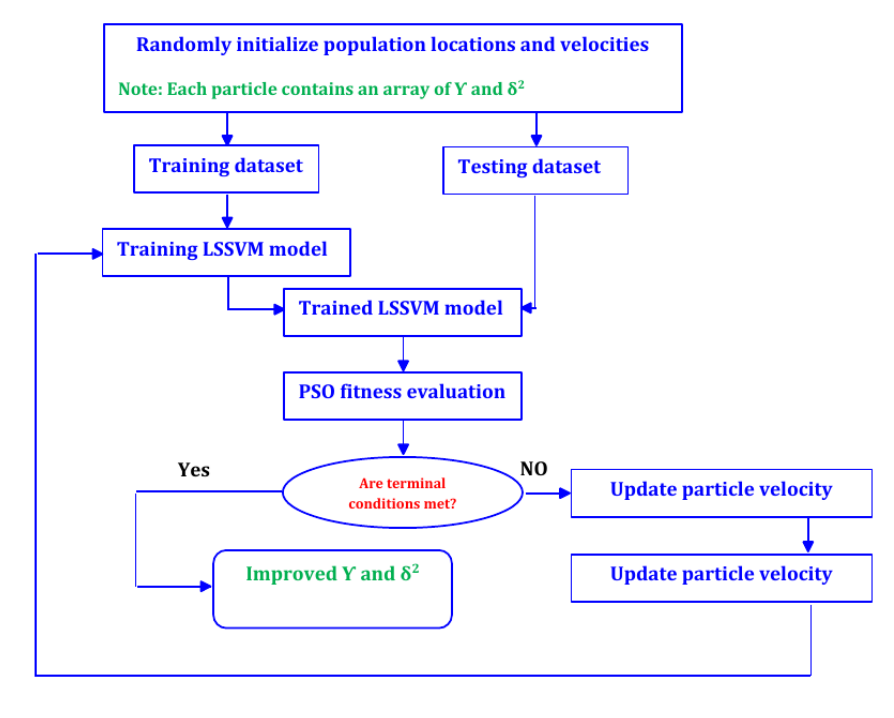
Figure 2. The overall scheme of the PSO-least squares support vector machine